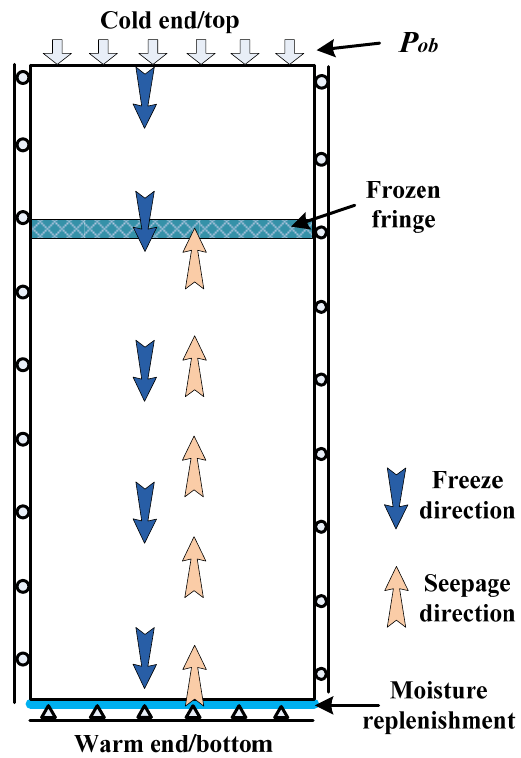
Figure 3. Schematic diagram of the soil column mechanical model.